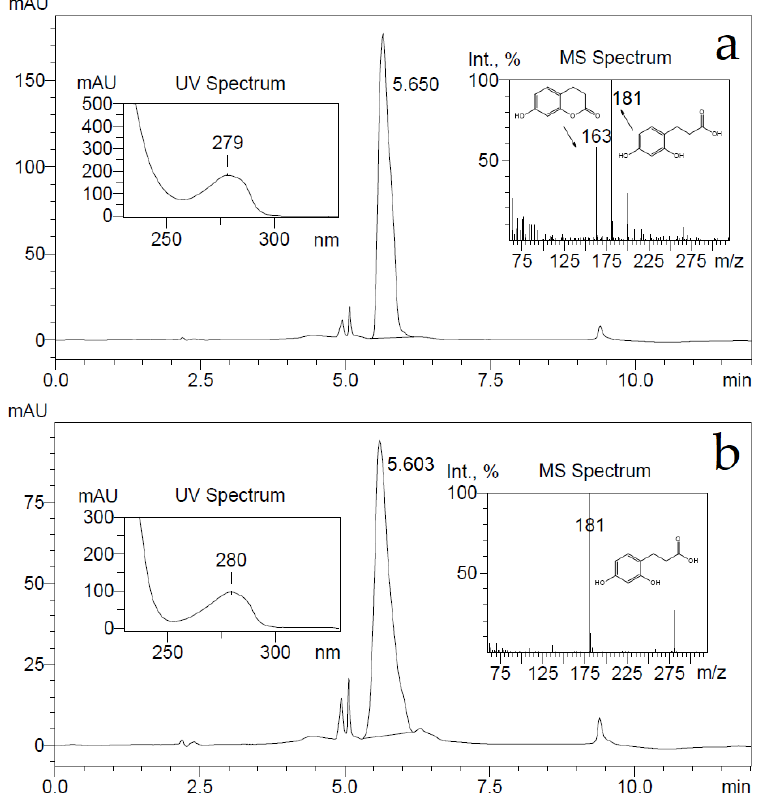
Figure 7. HPLC chromatograms of 7-hydroxy-3,4-dihydrocoumarin ( a ) and 3-(2,4-dihydroxyphenyl) propionic acid ( b ) at 280 nm wavelength. A sample of 2 mM of compounds was incubated in 50 mM potassium phosphate buffer (pH 7.2) for several hours and extracted by ethyl acetate. Corresponding UV and MS spectra of the main peaks are presented. The negative ions [M-H] − generated are at m / z 181 (3-(2,4-dihydroxyphenyl)propionic acid) and 163 (7-hydroxy-3,4-dihydrocoumarin). Further, the elution time of a compound from the 7-hydroxy-3,4-dihydrocoumarin sample was the same as one from the 3-(2,4-dihydroxyphenyl)propionic acid sample. A prolonged incubation (24 h) of 7-hydroxy-3,4-dihydrocoumarin in aqueous buffer solutions led to the disappearance of the [M-H] − ion mass of 163 Da in HPLC-MS analysis. This experiment confirmed that 7-hydroxy-3,4-dihydrocoumarin is prone to hydrolysis during incubation in aqueous solution and extraction by organic